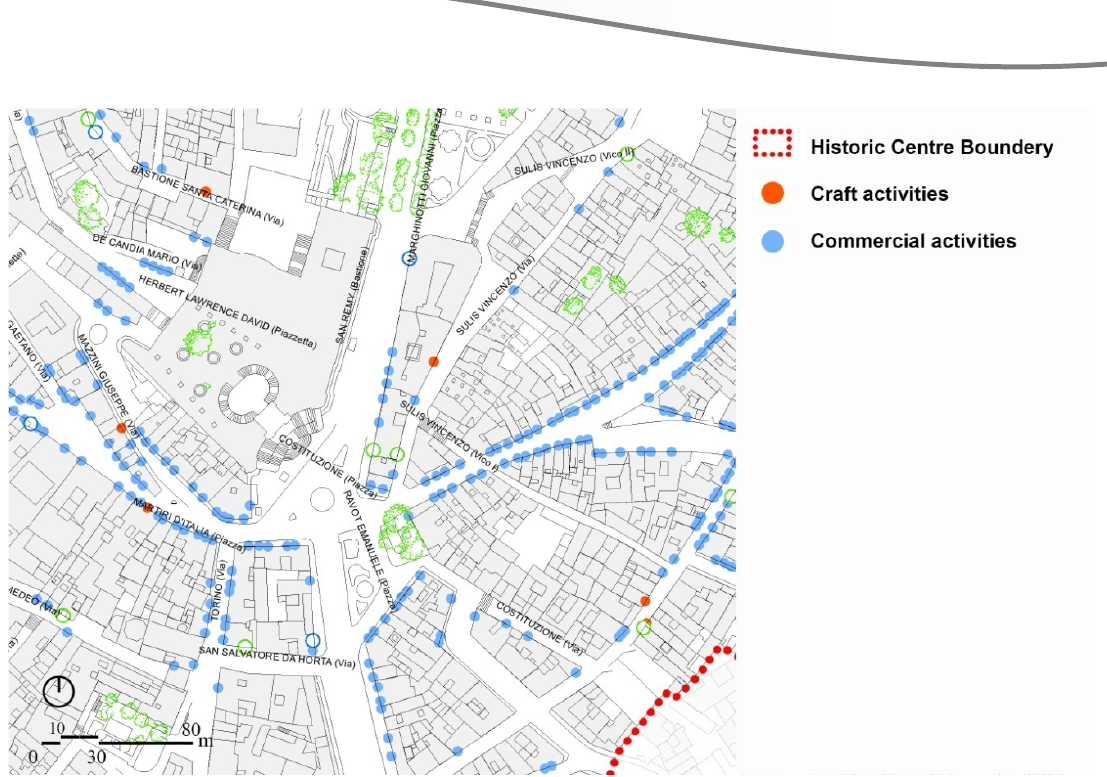
Figure 4: Map of the commercial businesses as of 2015 in the Detailed Plan for the City Centre. Considering the business locations, the map shows a different picture of Via Sulis compared to Figure 3 Source: Detailed Plan for the City Centre (Cagliari